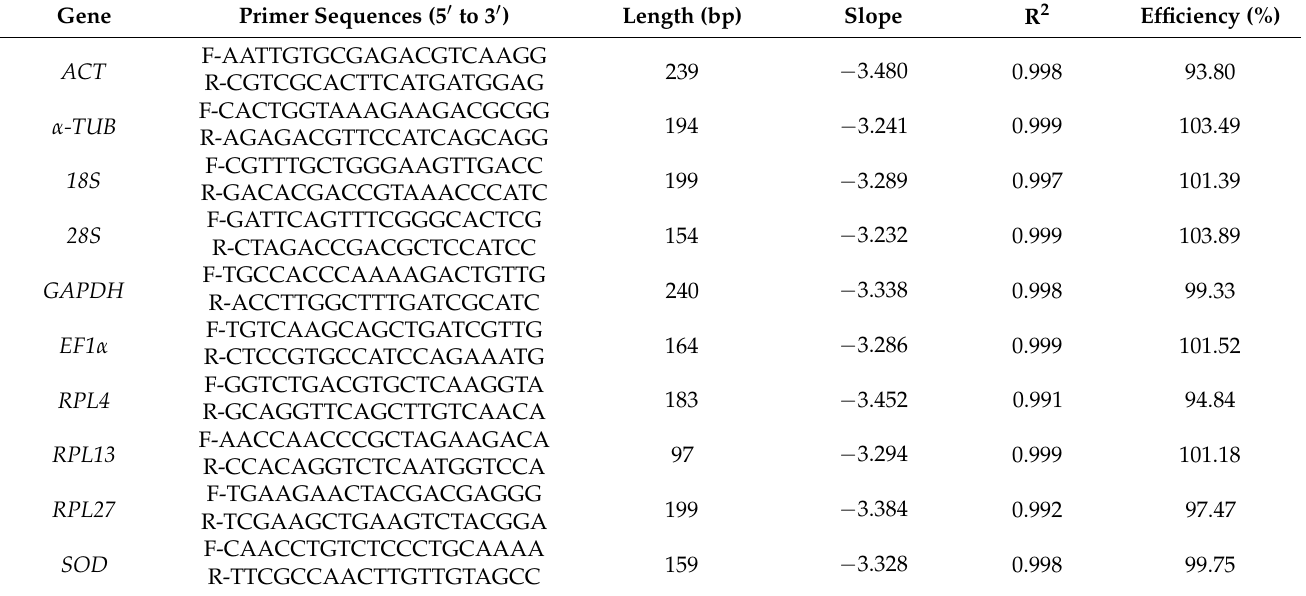
Table 2. Primers of 10 candidate house-keeping genes used in